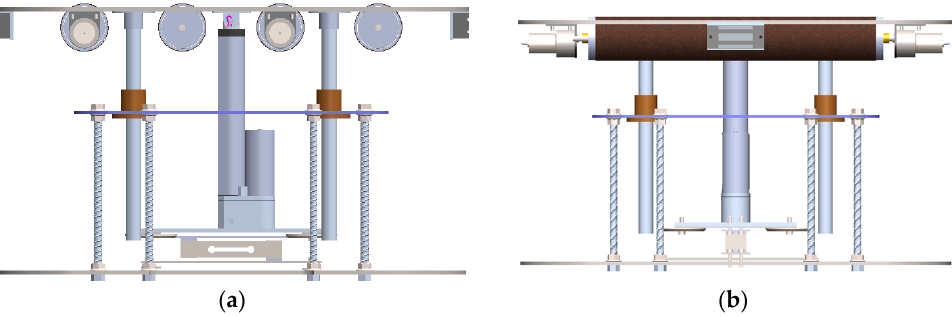
Figure 4. Inside architecture of loading and feeding mechanism: ( a ) side view, and ( b ) front